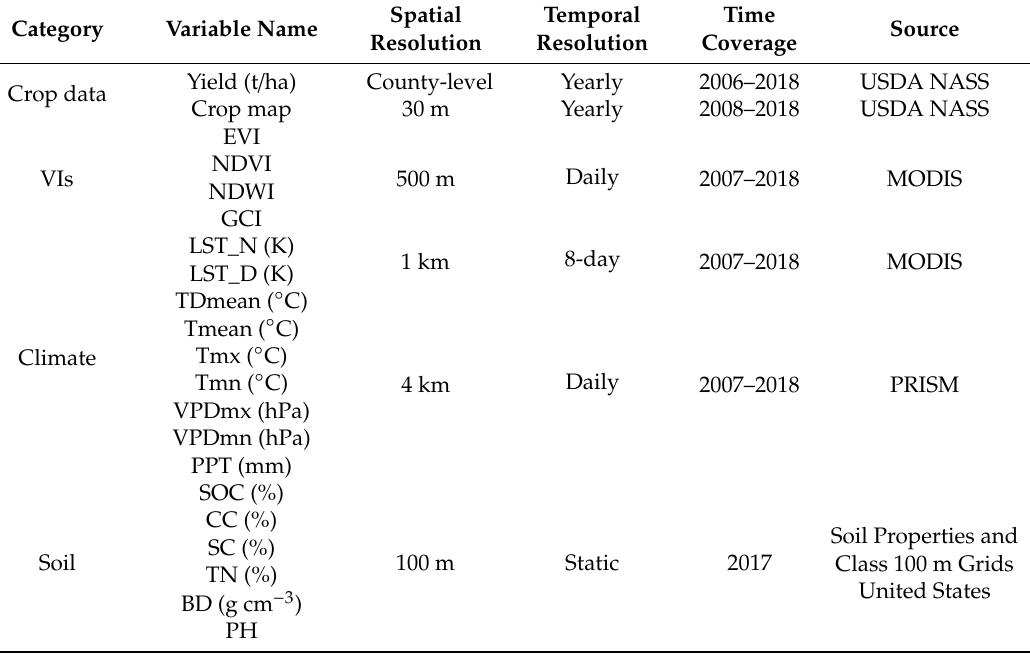
Table 1. A detailed summary of the input data for yield